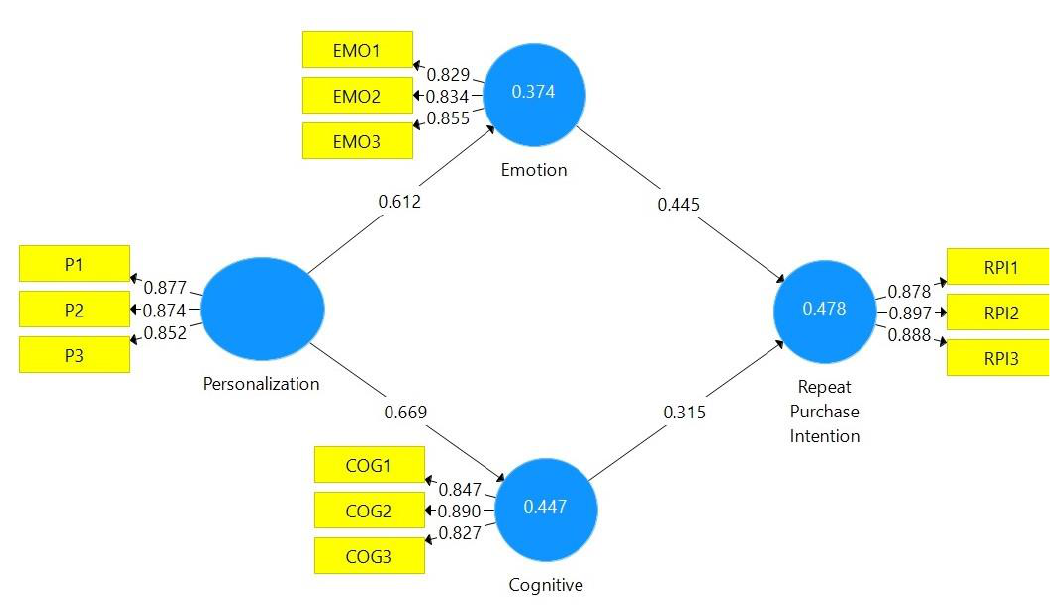
Figure 2. Validated